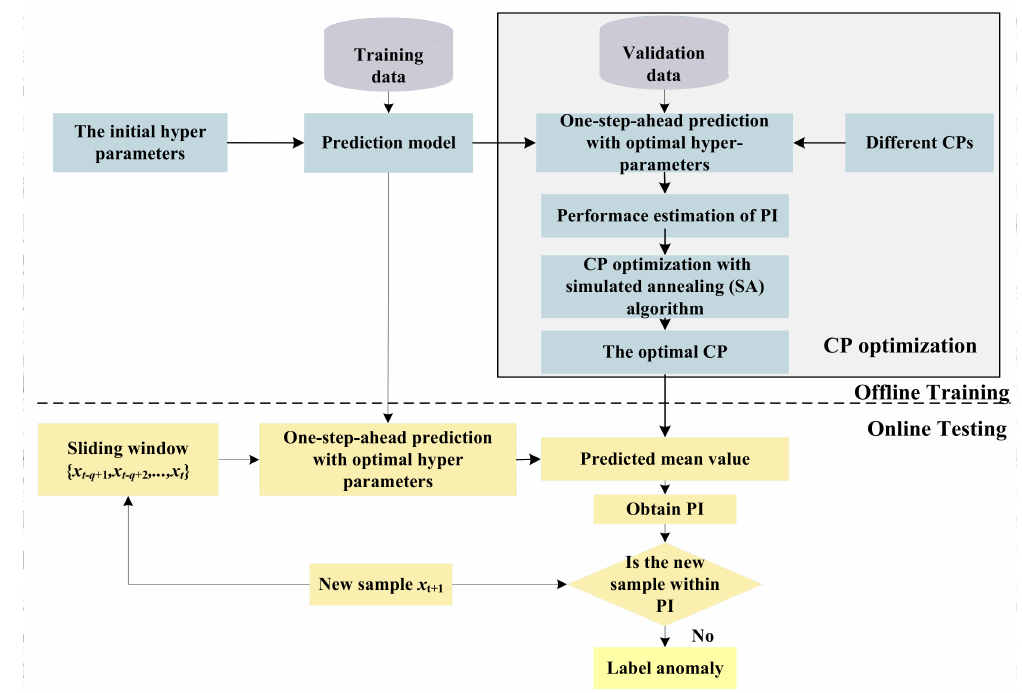
Figure 4. Anomaly detection framework with optimal